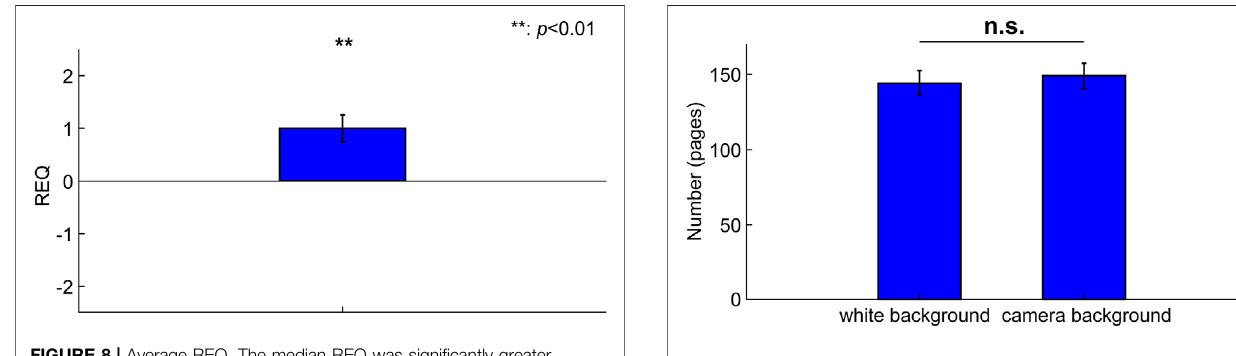
FIGURE 10 | Average number of pages of the book for each condition immediately after the task was completed. There was no signi fi cant difference between the two conditions. Error bars indicate the standard